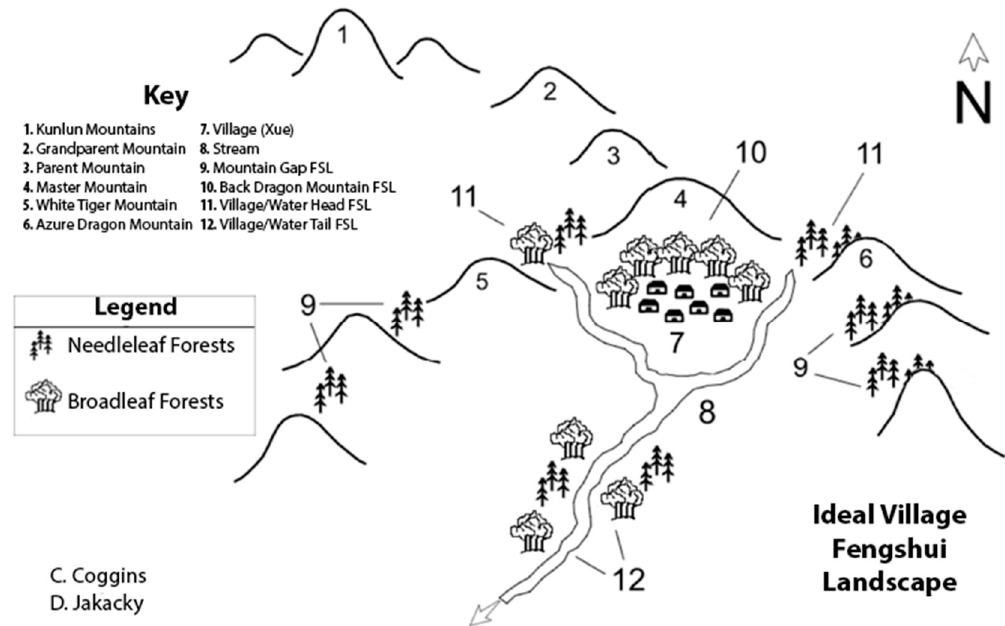
Figure 6. Village fengshui features, including landforms and fengshui forest types. (Coggins and Jackaky, 2016).